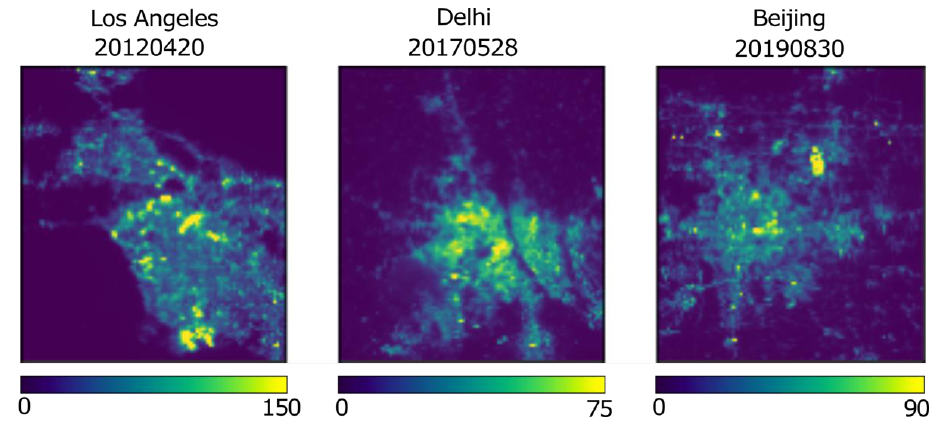
Figure 4. Sample VIIRS/DNB nightlight images (color indicates light intensity, unit: nW/cm −2 -sr).